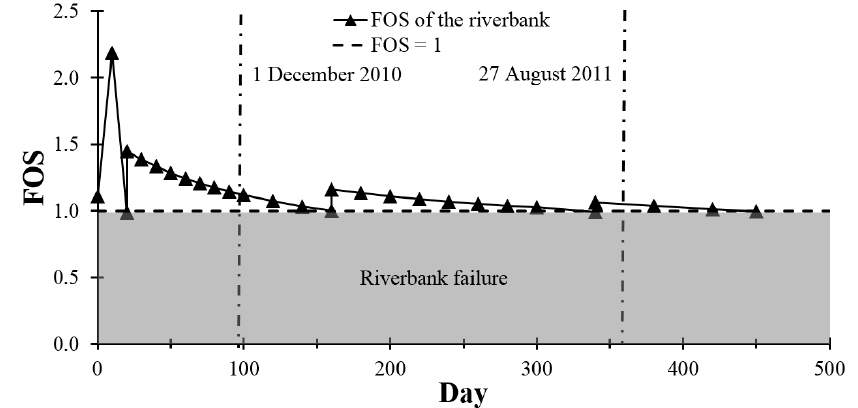
Figure 5. Time history of the riverbank stability of the junction between the Parlung Tsangpo River and Tianmo Gully; Factor of Safety (FOS) less than 1 denotes riverbank failure.